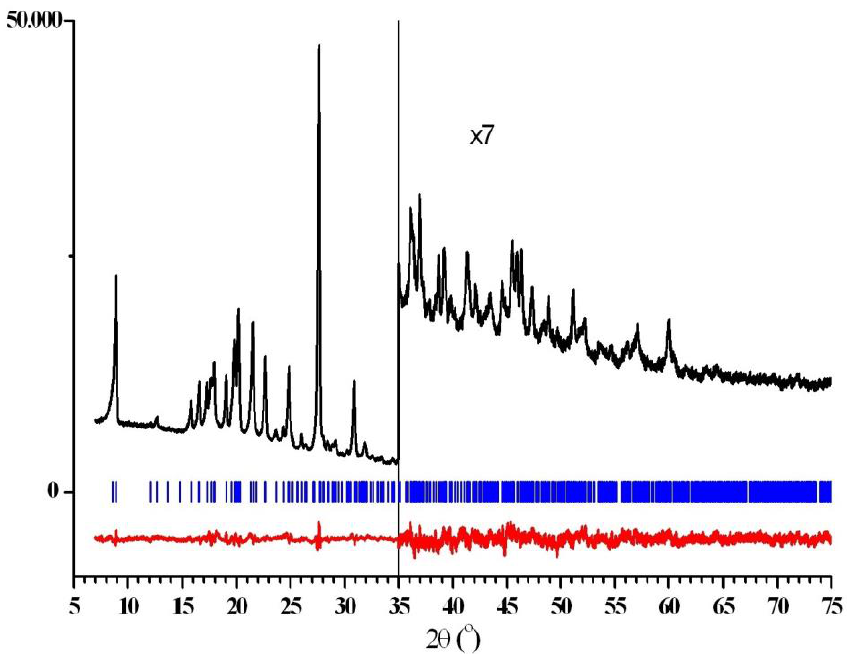
Figure 1. The final Rietveld plot for 4b showing the experimental diffraction profile in black and the difference (exp – calc) profile in red. The vertical blue bars correspond to the calculated positions of the Bragg peaks.